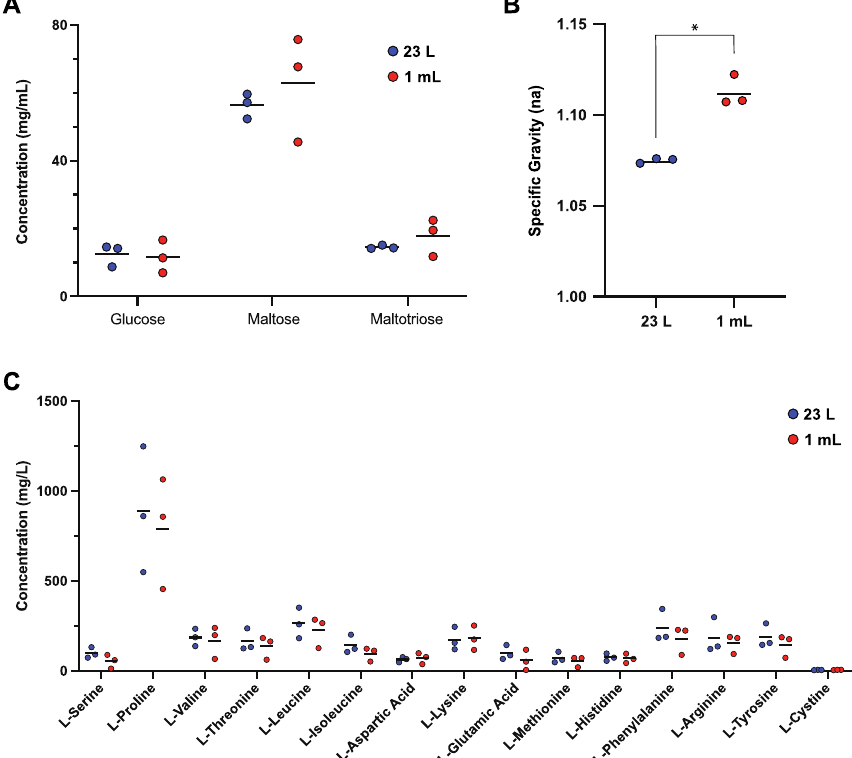
Figure 7. Wort parameters from a 23 L Braumeister mash and a 1 mL micro-scale mash. ( A ) Glucose, maltose, and maltotriose quantified in wort from a 23 L Braumeister mash (blue) and a 1 mL micro-mash (red). ( B ) Specific gravity. ( C ) Amino acids quantified in the two mashes. Bars show mean, n = 3. *, statistically significant ( p <